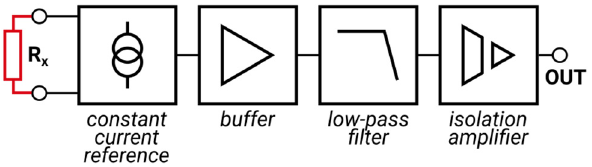
Figure 1. Block diagram of principal idea of custom transducer circuit.